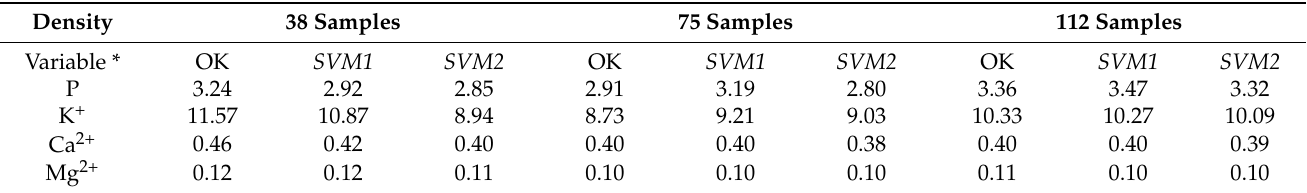
Figure 8. Coefficient of Determination ( R 2 ) calculated for the attributes P, K + , Ca 2+ , and Mg 2+ among three sampling grids for the test set. Table 2. RMSE values found for P, K + , Ca 2+ , and Mg 2+ for the sampling grids with grid of 38, 75, and 112 sampling points for the training set.